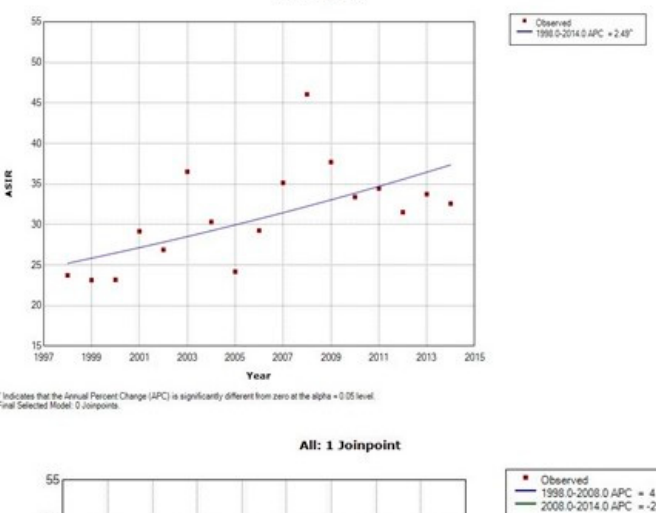
Table 2. Time trends of age-standardized incidence rates (ASIR) (cases/100,000) of cervical cancer, Cluj County, 1998–2014. Pathologic Sub-